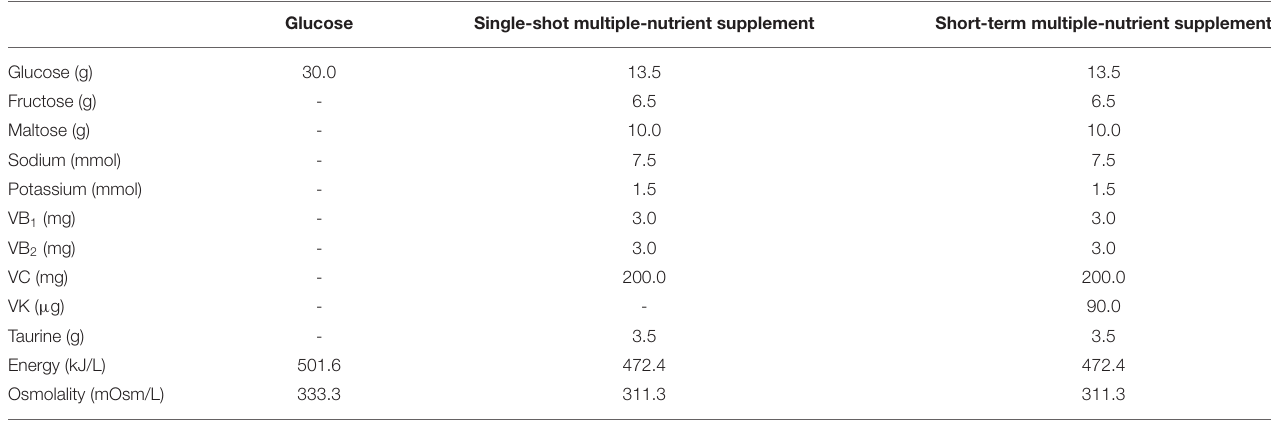
TABLE 1 | Components and dosage of each shot.